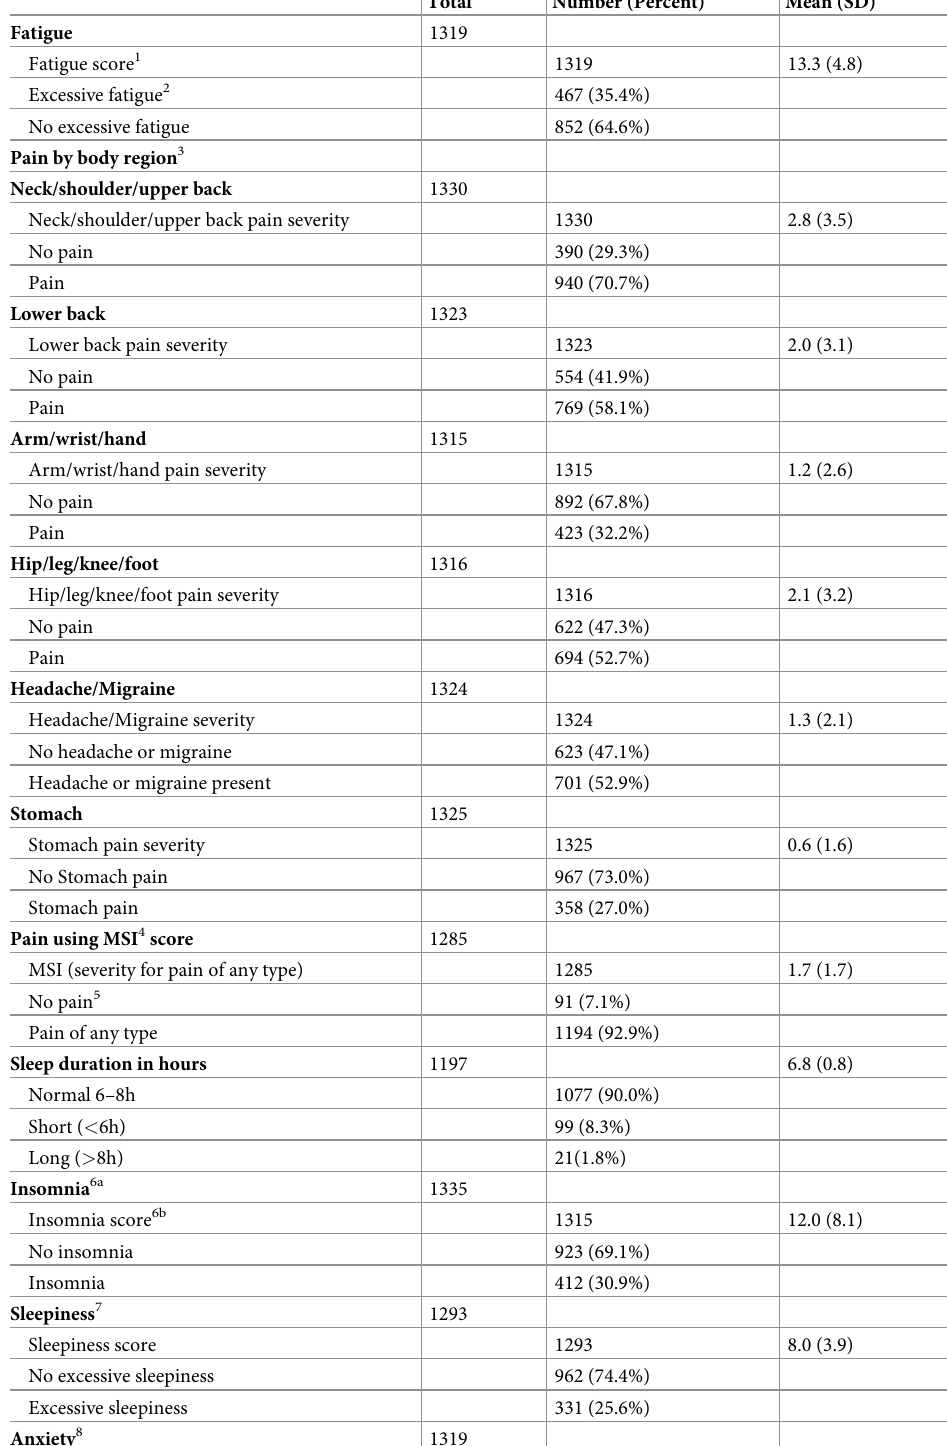
Table 2. Health of 1335 Norwegian nurses participating in the survey of shift work, sleep and health wave 10